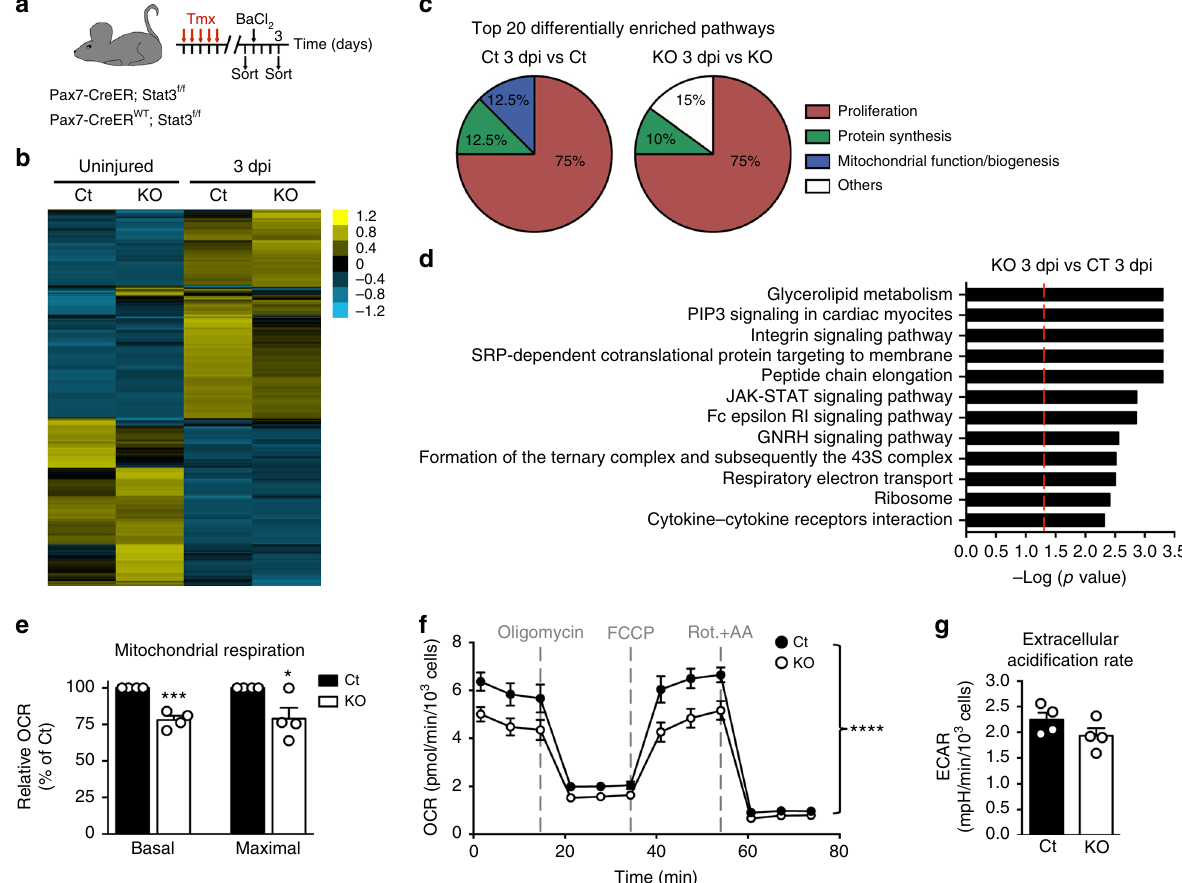
Fig. 1 Stat3 promotes mitochondrial function in muscle stem cells (MuSCs) during activation. a Scheme of the experimental design to obtain the samples for RNA-seq. b Heat map of the differentially expressed genes among the different comparisons. Listed genes were differentially expressed in at least one of the comparisons. Normalized gene RPKM (reads per kilobase of transcript per million) values were averaged within groups for the generation of the heat map ( n = 3 animals). c Pie charts showing the top 20 differentially enriched pathways (using Gene Set Enrichment Analysis (GSEA)) during the activation of control (Pax7-CreER WT ;Stat3 f/f ) or Stat3 KO MuSCs (Pax7-CreER;Stat3 f/f mice) grouped according to their functional category. d Top 12 pathways enriched in freshly isolated MuSCs from 3 dpi Pax7-CreER;Stat3 f/f mice compared to 3 dpi MuSCs isolated from control littermates using GSEA. The red line indicates p value = 0.05 based on the pathway analysis (GSEA). e – g Measurement of the oxygen consumption rate (OCR) and the extracellular acidi fi cation rate (ECAR) of control and Stat3 KO MuSCs cultured in growth conditions for 3 days ( n = 4 independent experiments). The Cell Mito Stress Test was performed in a Seahorse XFp Analyzer. Data are represented as mean ± SEM (Student ’ s t test or two-way analysis of variance; * p < 0.05, *** p < 0.001, **** p <